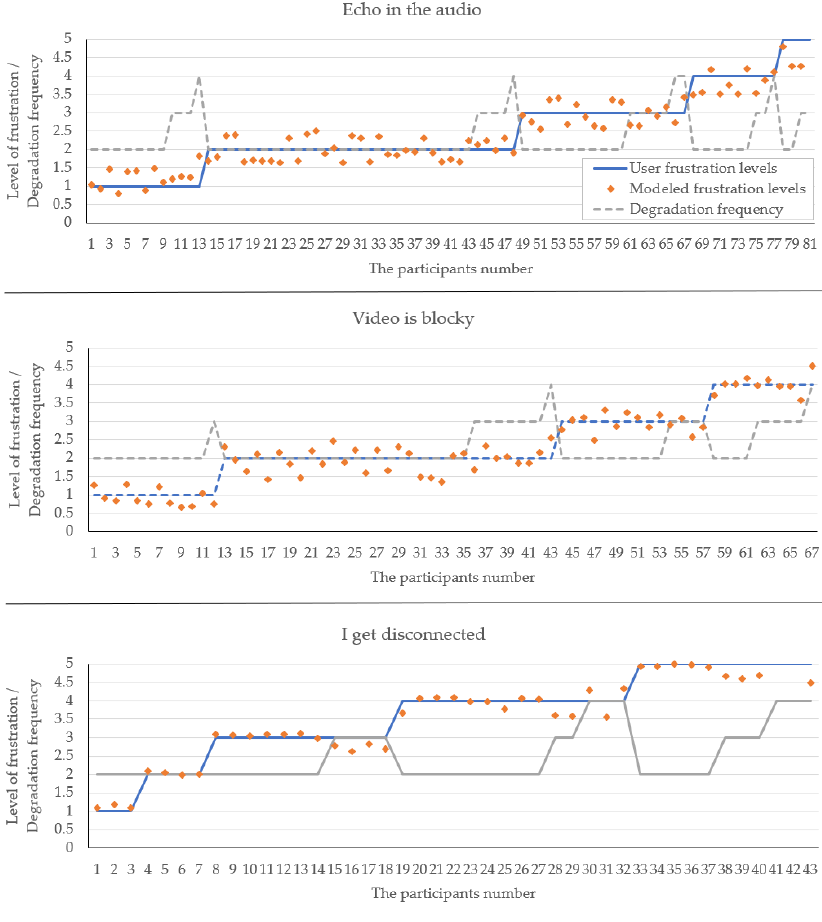
Figure 8. Using the test data sets, participants’ frustration levels, degradation frequency, and modeled frustration levels (with UFSI) for three quality degradation types.